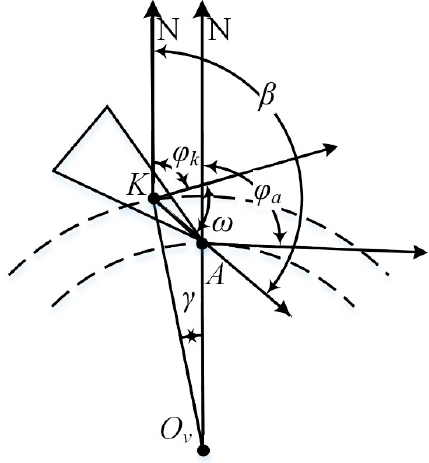
Figure 5. Instantaneous uniform circular motion of ship.